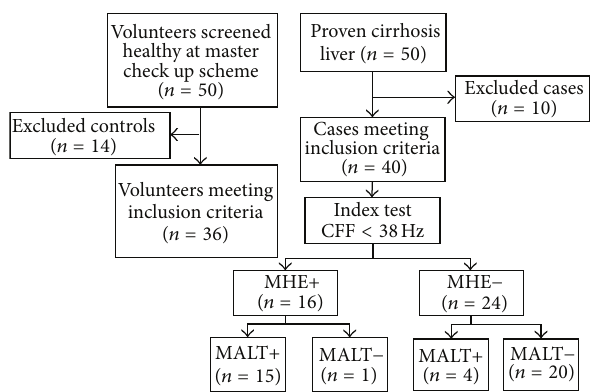
Figure 2: Study design flowchart according to the STARD guide- lines.